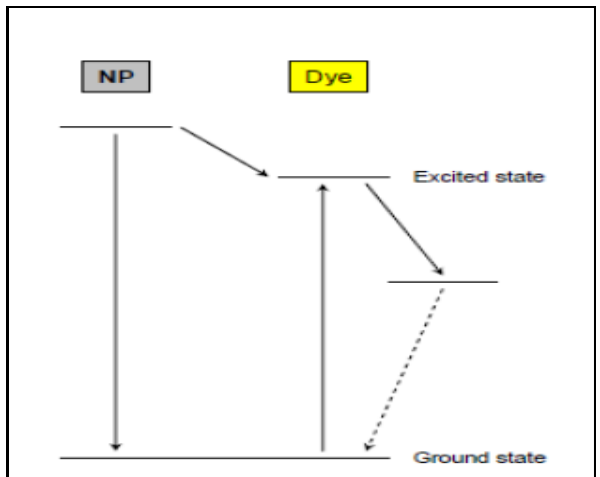
Figure 11: Energy diagrams describing surface plasmon-dye interaction, Surface enhanced fluorescence